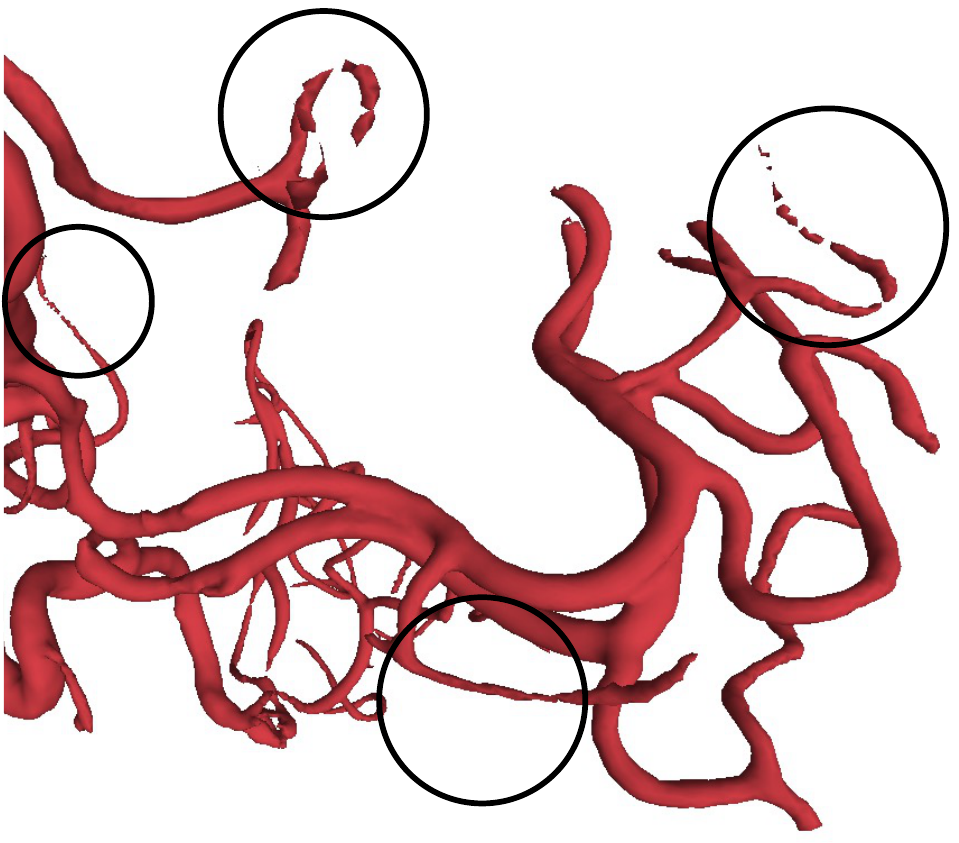
Figure 3. Visualization of incomplete IntrA raw dataset. Incomplete parts are circled.